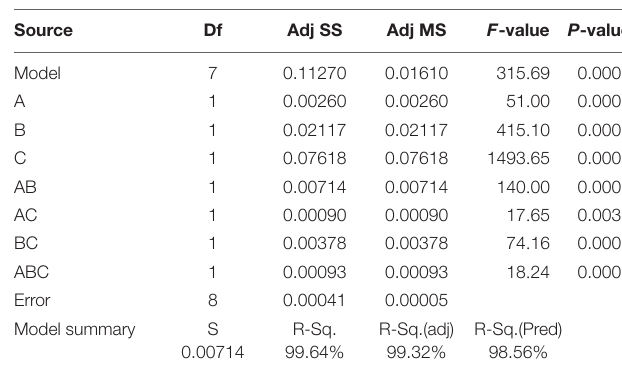
TABLE 3 | Analysis of variance (ANOVA) of factors and interactions including the degrees of freedom (Df), the adjusted sum of squares (Adj SS), the adjusted mean of squares (Adj MS), F -values and P